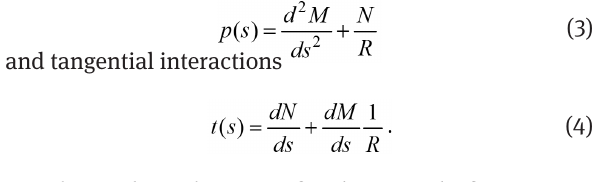
Figure 5: Diagrams of bending moments with regards to the backfill thickness z . g